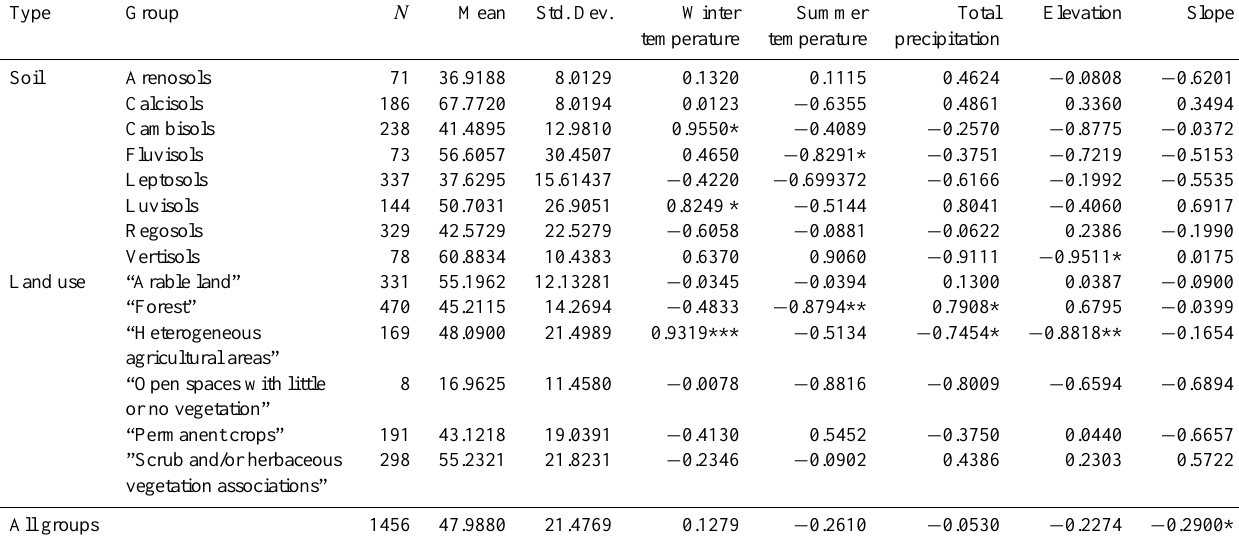
Table 3. Mean soil organic carbon content (Mgha − 1 ) and standard deviation for each soil and land use type and correlation coefficients between soil organic carbon content and environmental variables. (*) p ≤ 0 . 05; (**) p ≤ 0 . 01; (***) p ≤ 0 . 001. Non-significant correlation coefficients are not